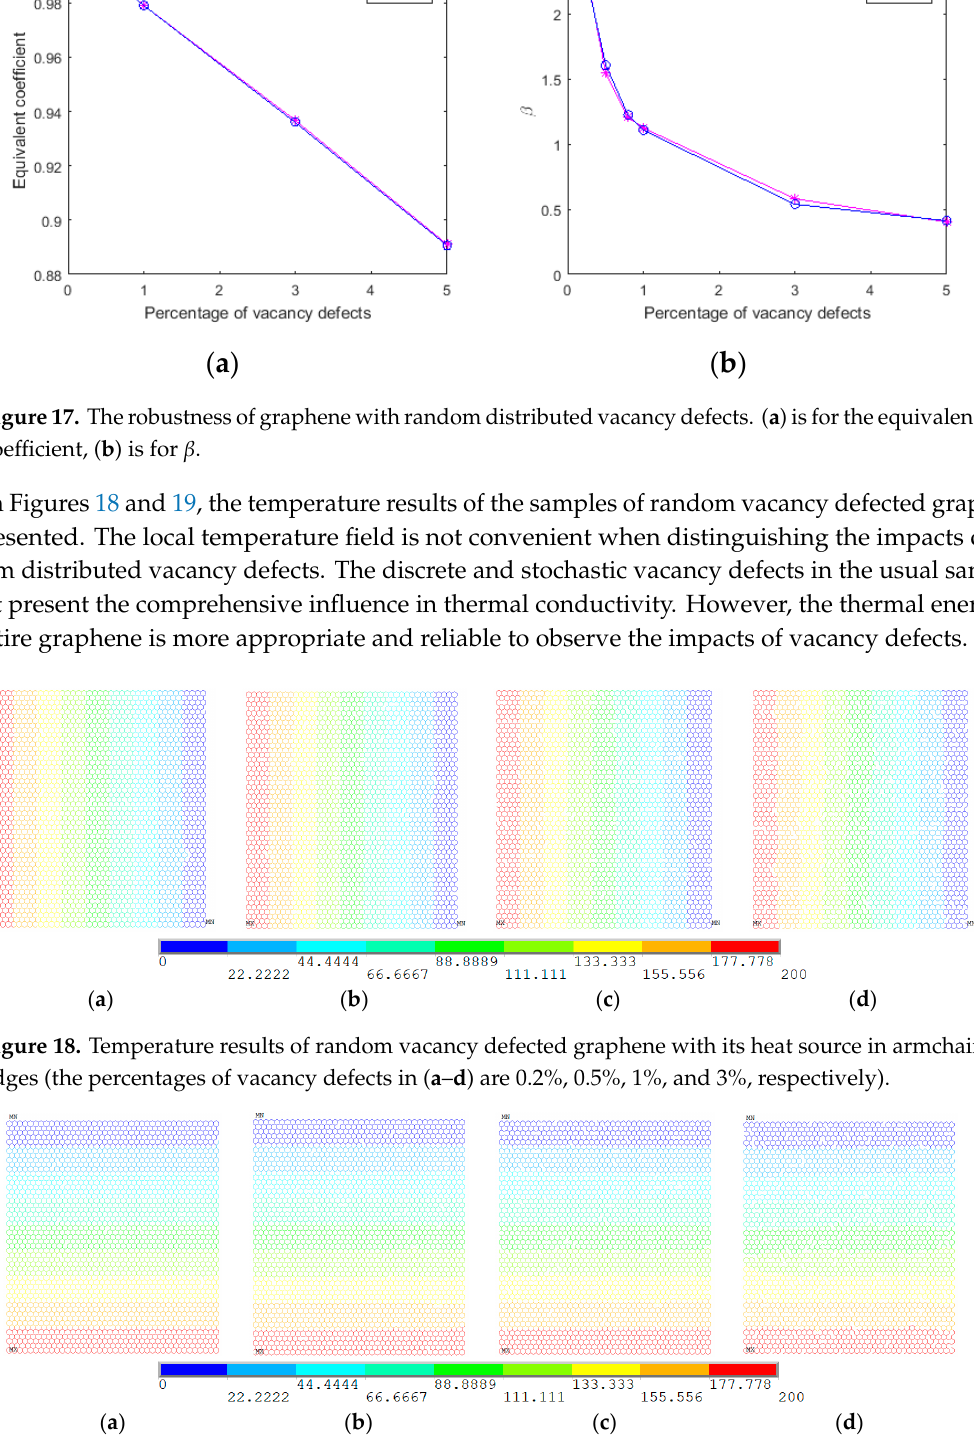
Figure 19. Temperature results of random vacancy defected graphene with its heat source in zigzag edges (the percentages of vacancy defects in ( a – d ) are 0.2%, 0.5%, 1%, and 3%, respectively).